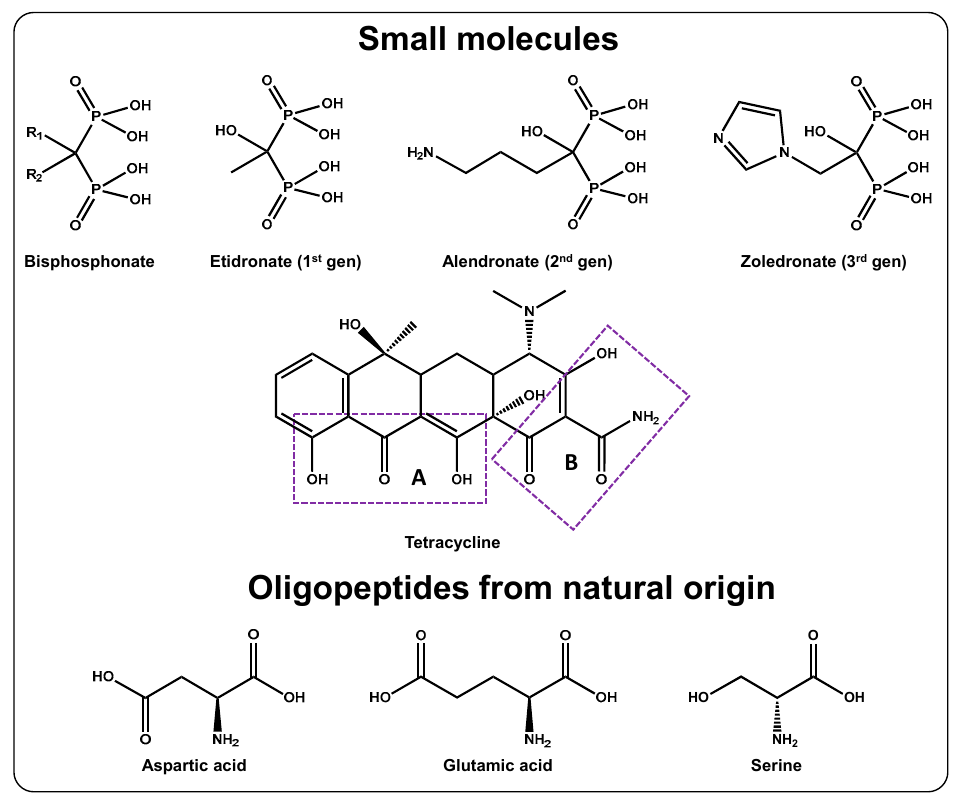
Figure 3. Small molecules and macromolecules that target the bone surface. Top and middle: small FDA-approved molecules. Bottom: amino acids employed in the design of oligopeptides from natural origin.